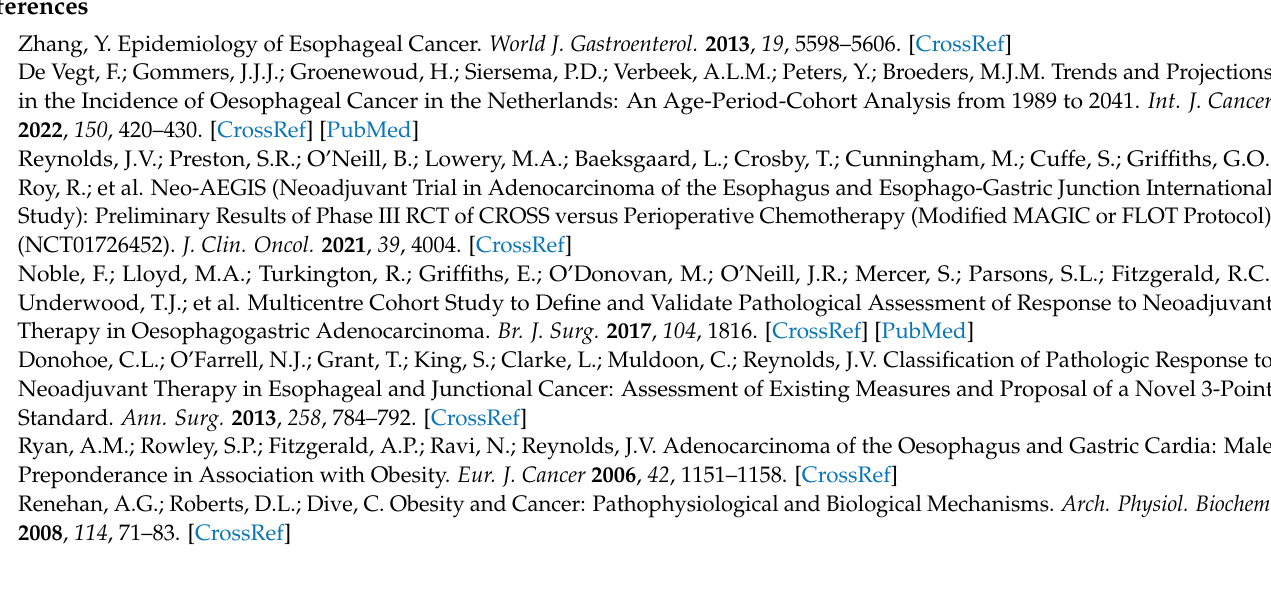
Figure 2E between experimental data and factors associated with metabolic dysfunction and systemic disease; Table S2: Significant correlations associated with Figure 3E for clinical correlations with neo-adjuvant treatment, chemotherapy only, chemoradiotherapy and experimental data; Table S3: Significant correlations associated with Figure 3E for clinical correlations with differentiation, lymph involvement, venous involvement and perineural involvement; Table S4: Significant correlations associated with Figure 4D for clinical correlations with tumour regression grade, clinical